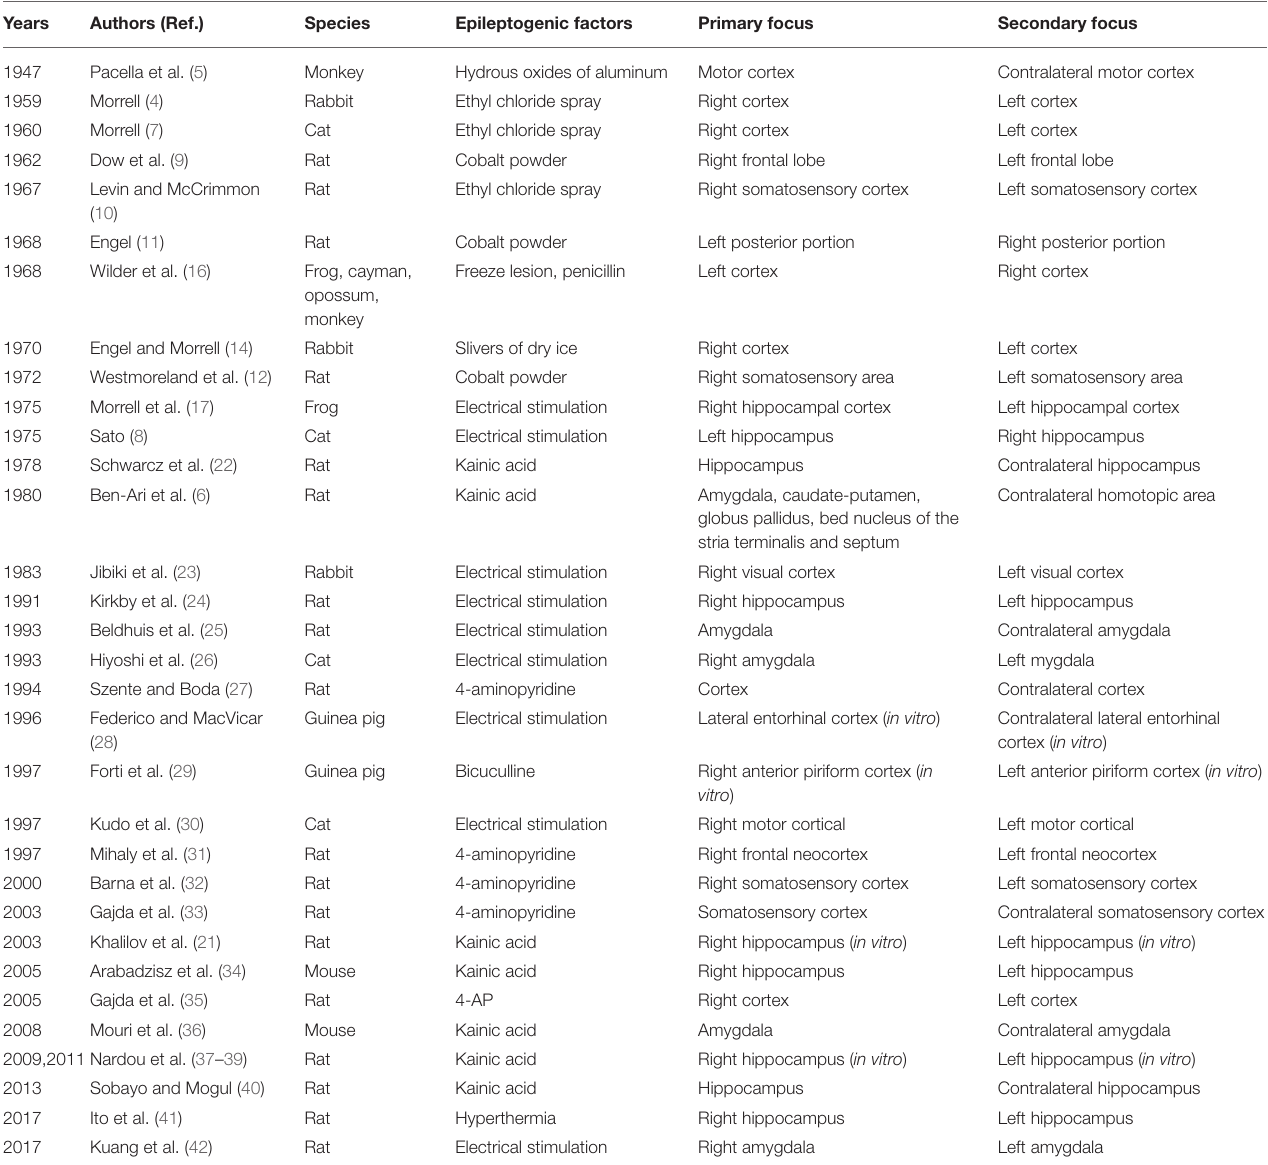
TABLE 1 | Secondary epileptogenesis in animal